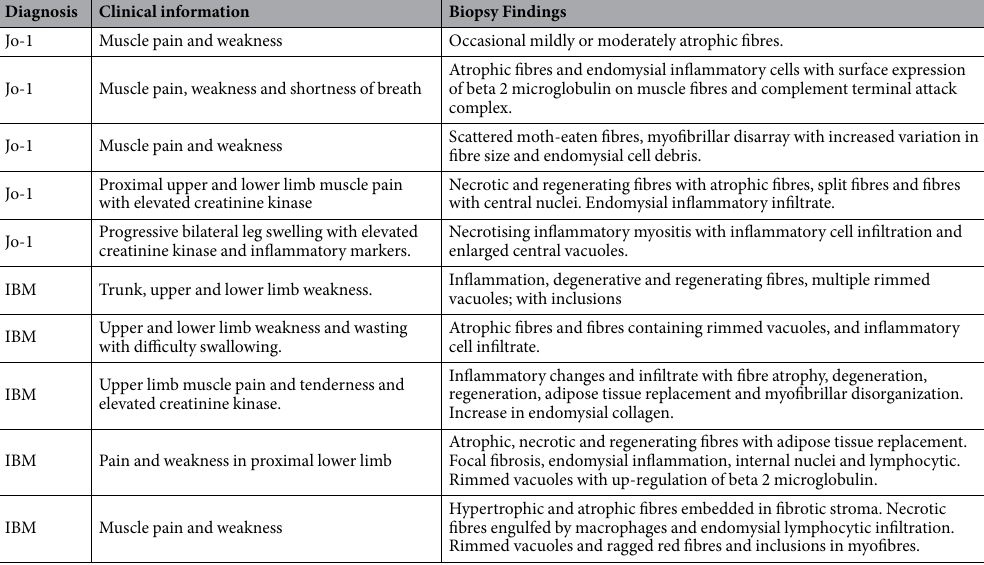
Table 1. Histological description of individual patient